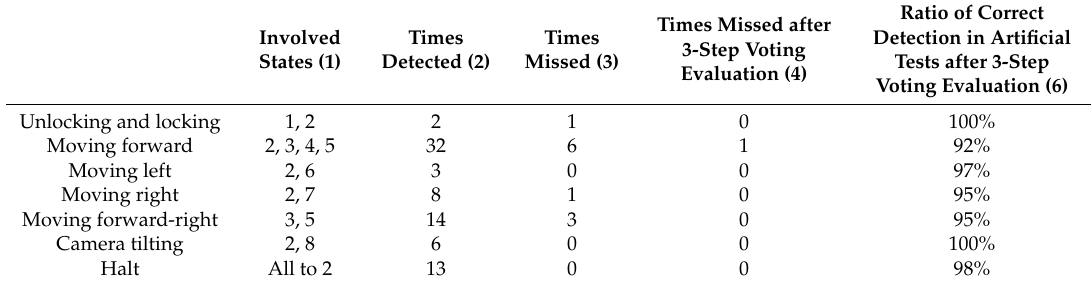
Table 8. Accuracy of the detection of gesture sequences to reach the state needed to determine the path of the robot in Experiment 4 and in artificial tests of the navigation between states (100 trials per